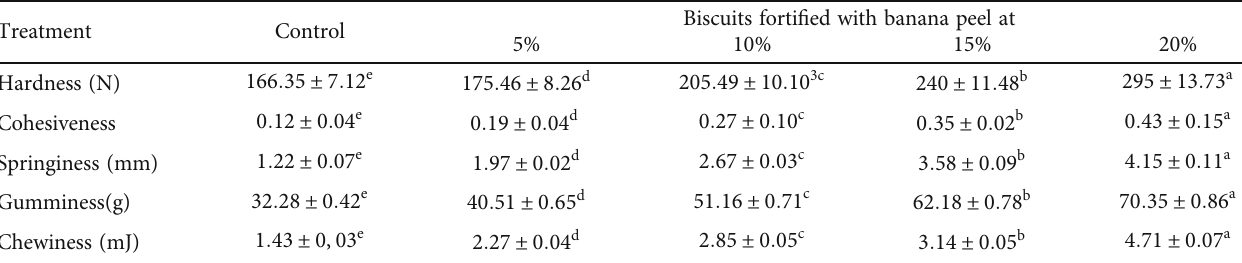
Figure 2: Color in di ff erent blends of biscuit. Table 6: E ff ect of banana peel on texture characteristics of biscuits.